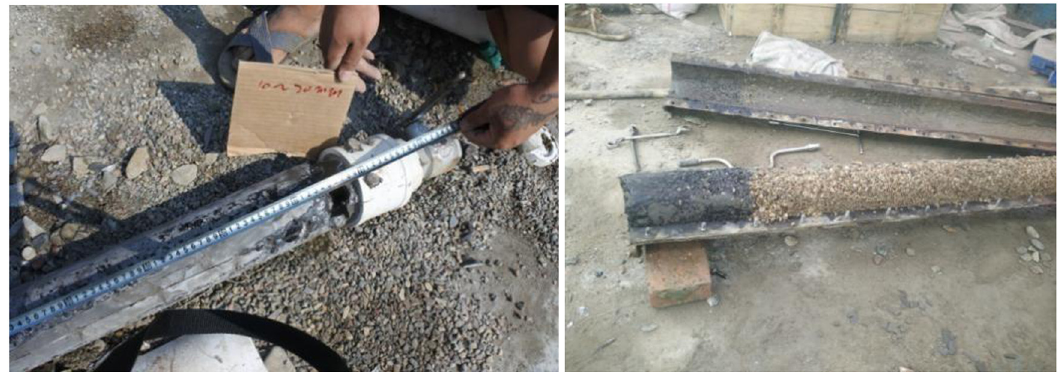
Figure 8: 1D experiment model after grouting low - thermal